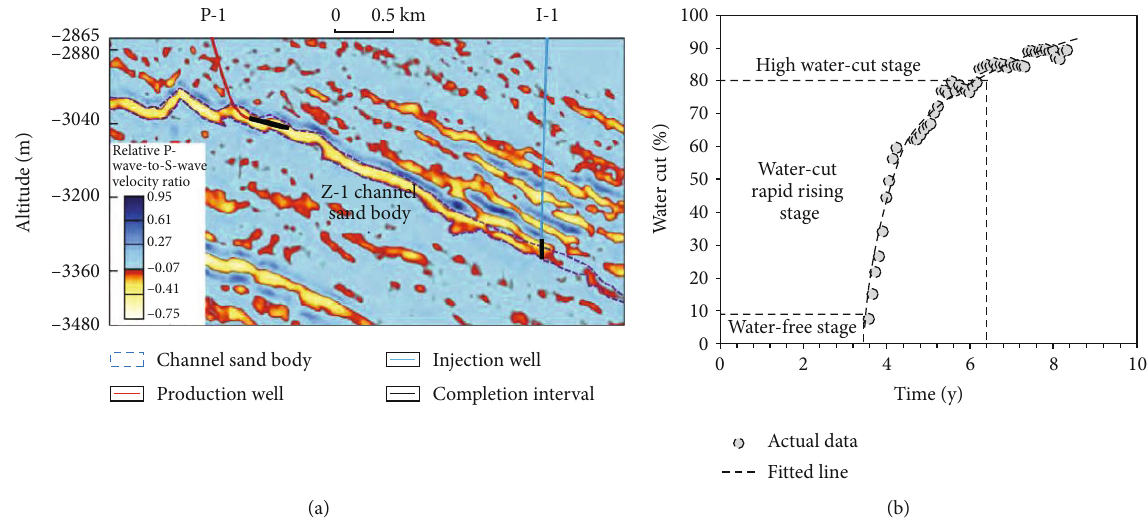
Figure 1: A typical well of Mode I: (a) seismic section images; (b) water-cut changing